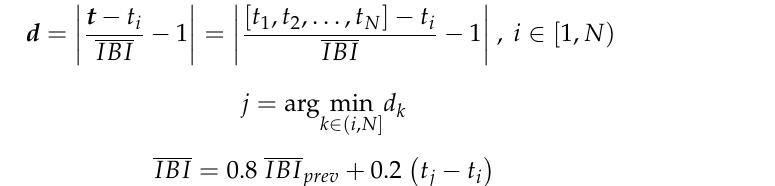
Figure 2. Application of the described interpolation strategies ( a : SPLINE; b : PARABOLA; c : REG) to the peaks identified through the ENVELOPE method. The first derivative of a PPG signal sam- pled at 32 Hz is shown (blue dots). The following is in red: spline-interpolated first derivative ( a ), parabola approximation ( b ), regression curves estimated on the ascending and descending seg- ments ( c ). The plots show the peaks detected on the subsampled signal (O) and those identified through interpolation (X).